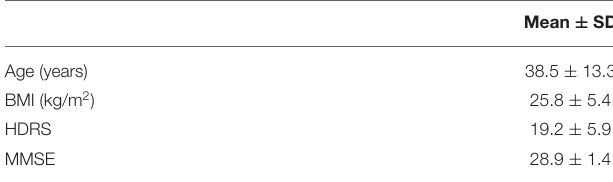
TABLE 1 | Basic characteristics of the respondents ( n = 41